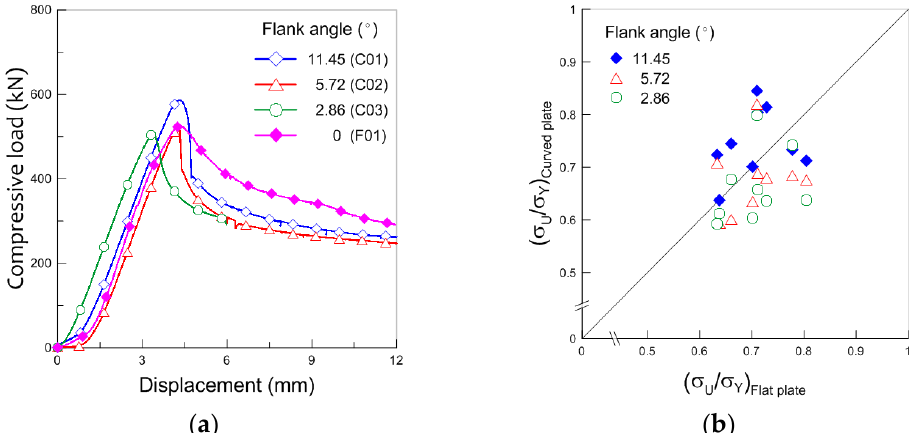
Figure 6. ( a ) Compressive load versus displacement curves of curved plates and ( b ) comparison of ultimate strengths of curved and flat plates.